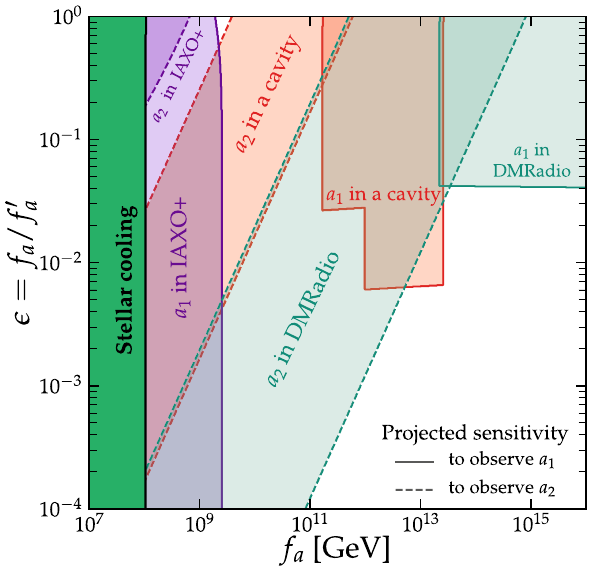
Fig. 3 Projected sensitivity for loosely-defined future experiments: an upgraded version of IAXO [83], resonant cavity experiments covering the 1–100 µ eV region (based on projections from [84]), and DMRadio- like experiments covering the neV– µ eV region (based on [60]). In the parts where the a 1 and a 2 regions overlap, the signal from both axions will be seen – a characteristic of the companion axion model. For some small regions the signal of the two axions could even be seen in the same